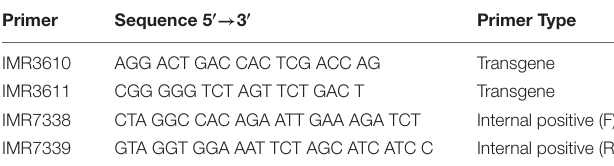
TABLE 1 | Primers sequences for standard multiplex PCR